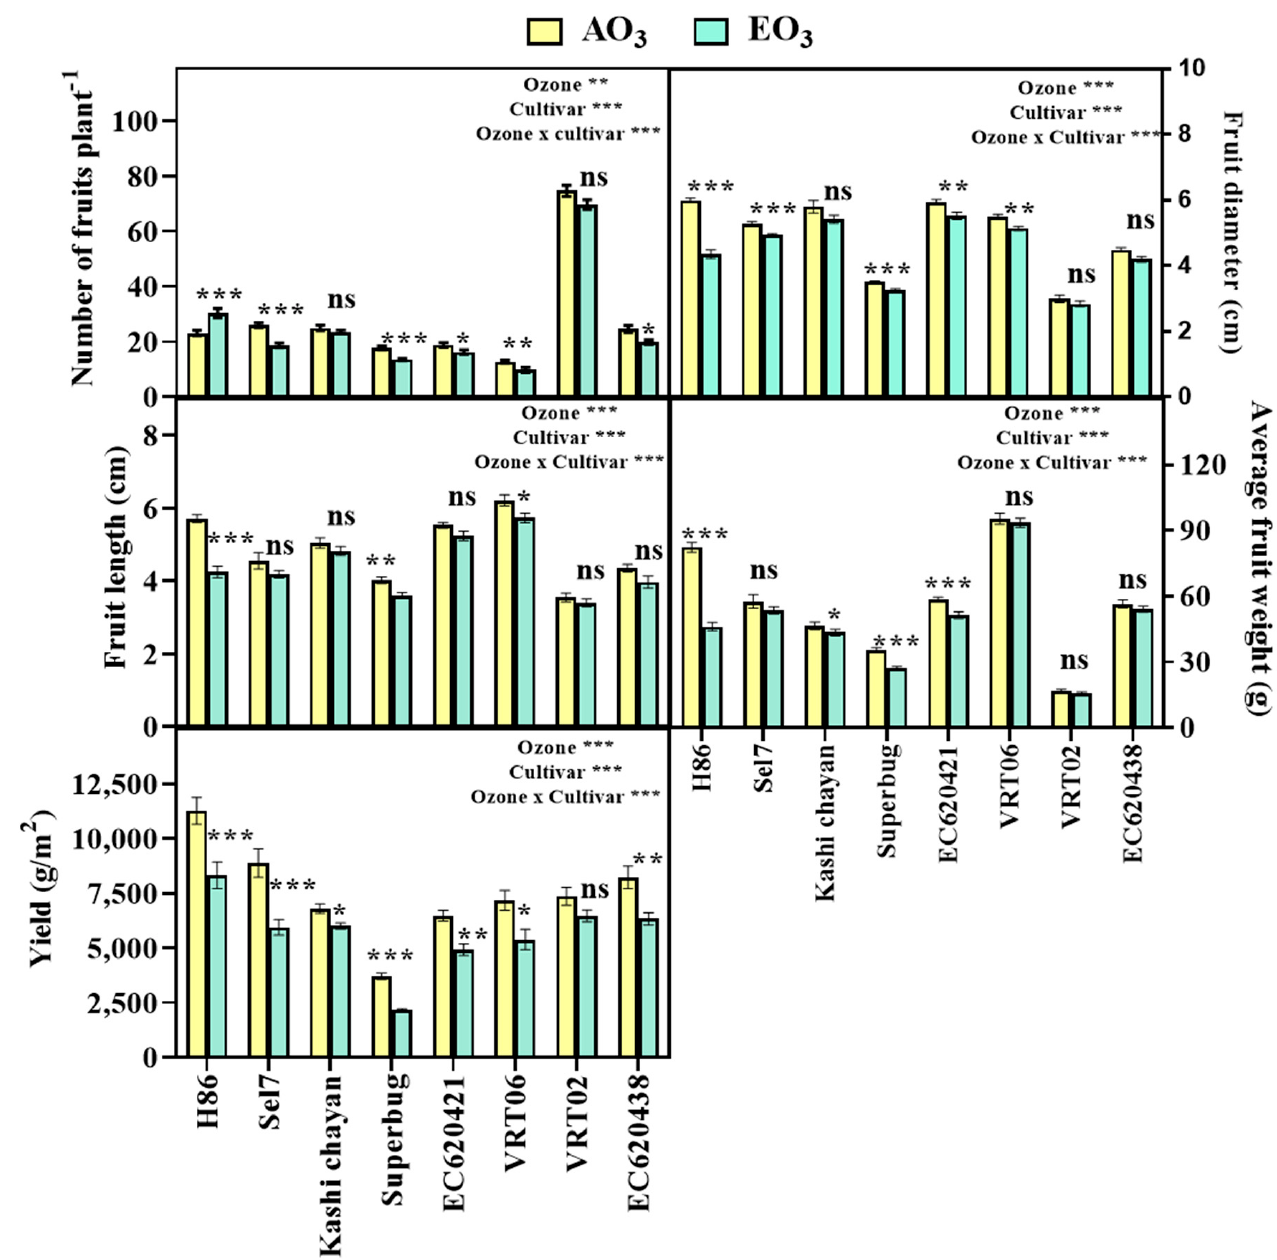
Figure 8. Number of fruits per plant, average weight of fruit, fruit length, fruit diameter and yield of the test tomato cultivars under ambient O 3 (AO 3 ) and elevated O 3 (EO 3 ) treatments. Values are mean ± SE. Level of significance between AO 3 and EO 3 based on t -test: * p ≤ 0.05; ** p ≤ 0.01; *** p ≤ 0.001; ns not